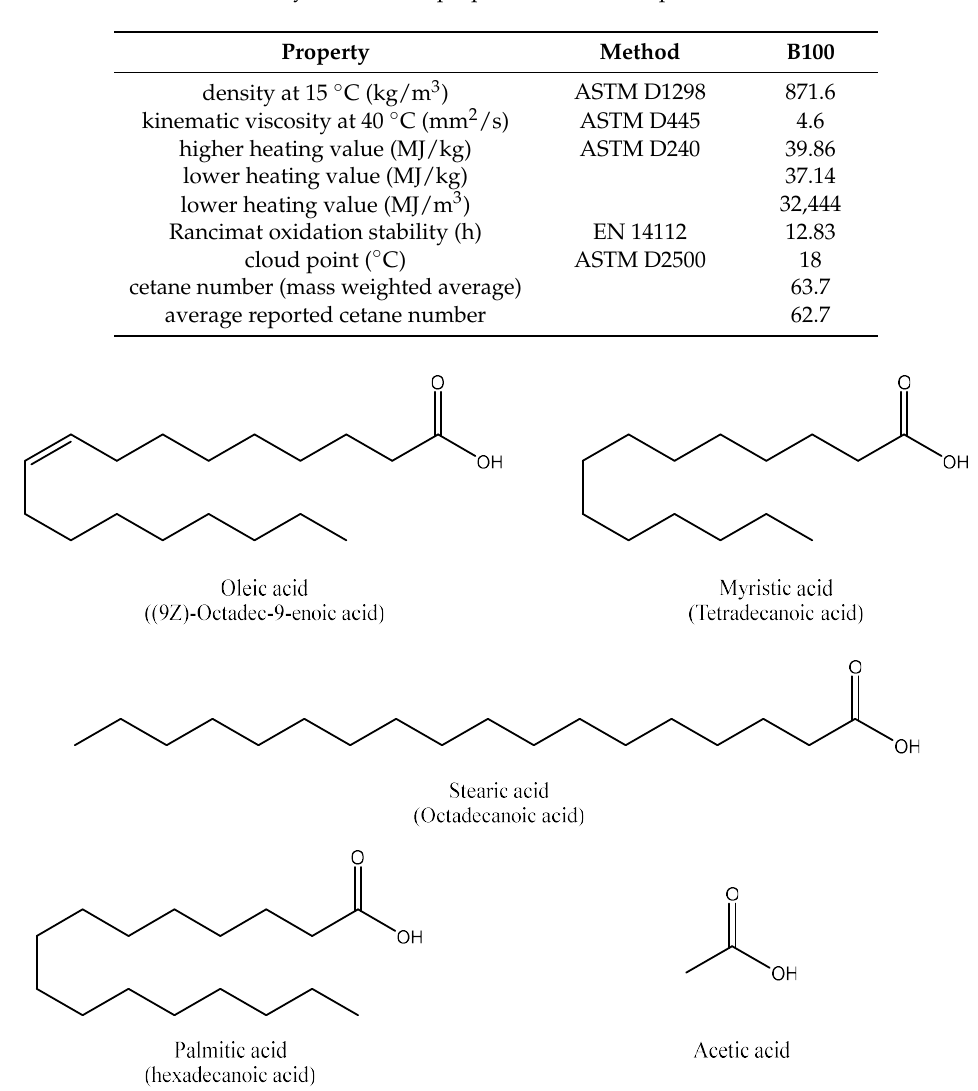
Table 2. Physicochemical properties of the used palm biodiesel.